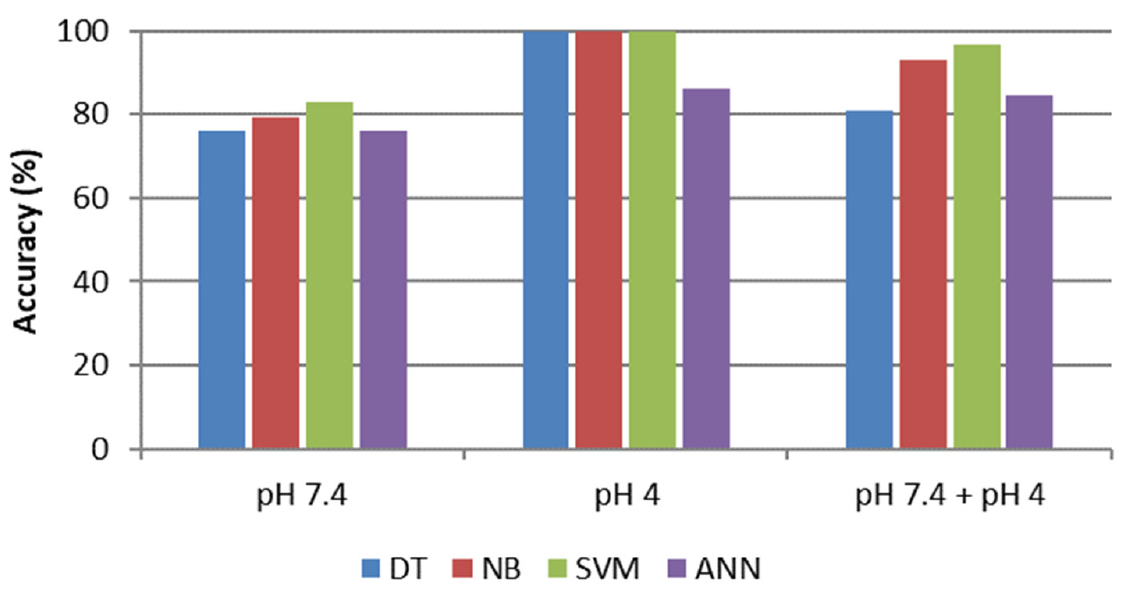
Figure 6. Testing classification accuracy for copper ion discrimination in MEM at different pH conditions.